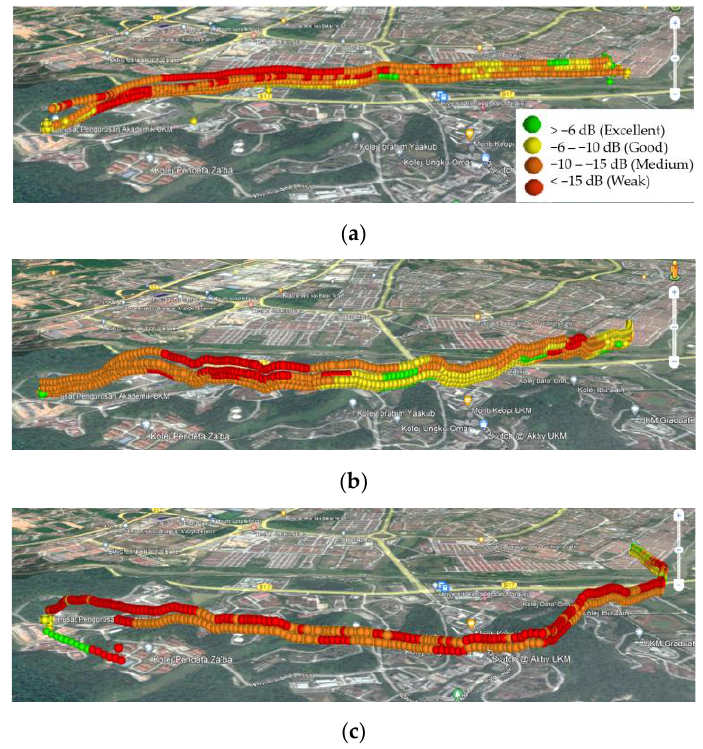
Figure 18. RSRQ measurements for the aerial drive test on the UKM campus at different heights (65, 85, 105, and 125 m) and different routes: ( a ) Route I, ( b ) Route II, and ( c ) Route III.